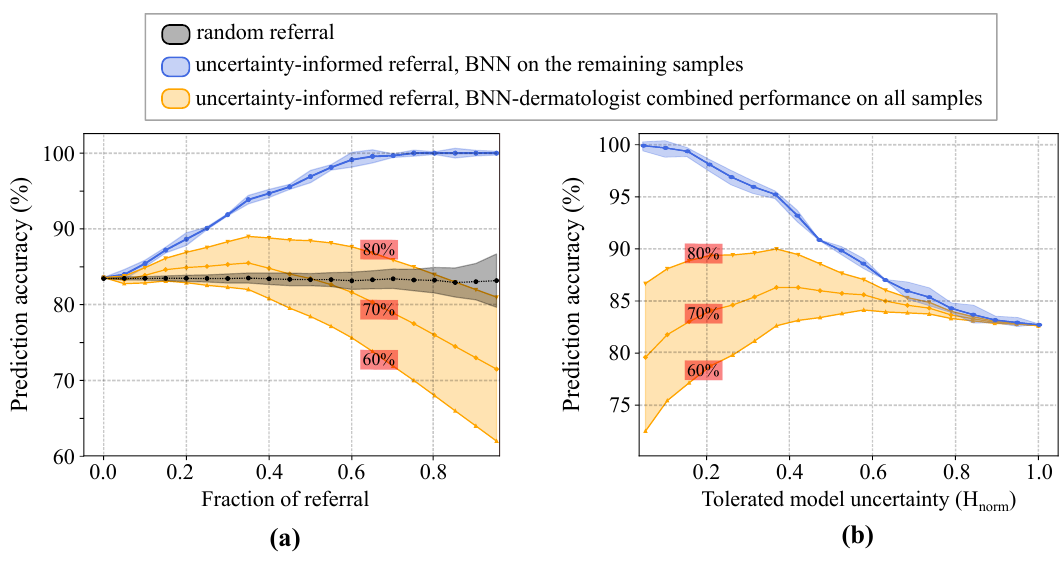
Figure 8. Enhanced prediction accuracy of physician–machine team via uncertainty-aware referral. ( a ) The classification accuracy as a function of the fraction of referral. The black curve shows the effect of rejecting the same number of samples randomly (i.e., with no use of uncertainty information). ( b ) The classification accuracy as a function of the tolerated amount of normalized model uncertainty. The shaded areas around the blue and black curves show one standard deviation for the five-fold cross-validation. For the BNN–dermatologist curves (shown in orange), the corresponding stand-alone performance of the dermatologist is shown in the red box on each